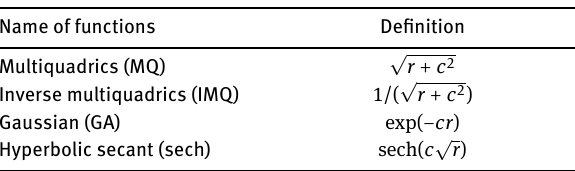
Table 1: Some well-known radial basis functions ( r = (cid:107) x − x i (cid:107) 2 = r i ), c >